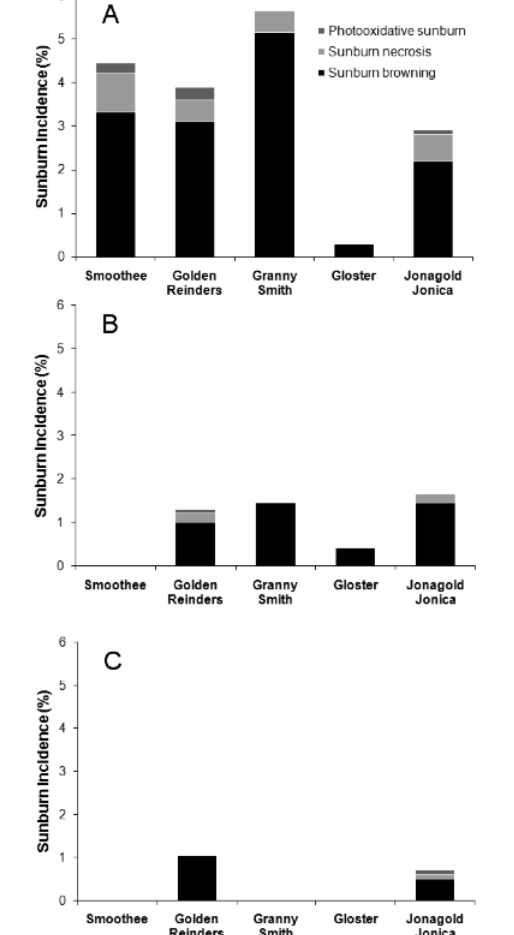
Fig. 1. Sunburn incidence of five apple cultivars and the share of each type of sunburn on M.9 (A), MM.106 (B) and seedling (C) rootstocks at harvest. Data are based on the average of 2006 and 2007.